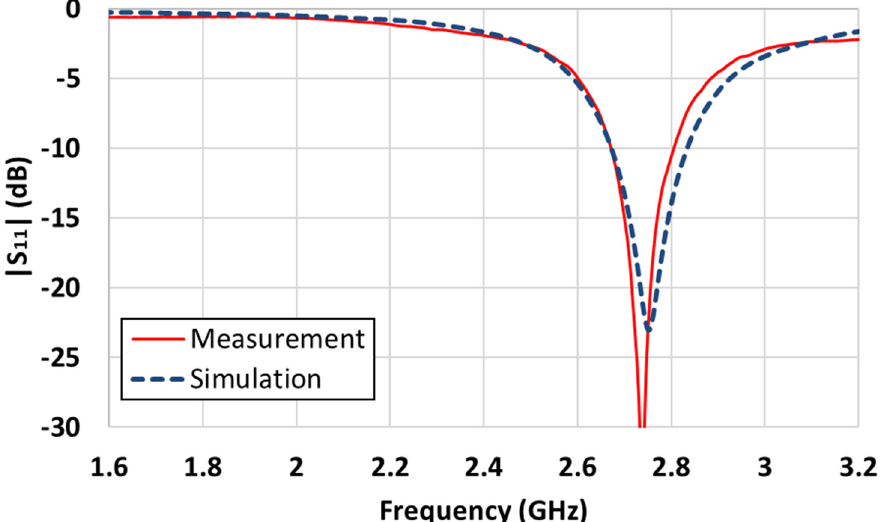
Figure 7. Constructed antenna: ( a ) complete structure, ( b ) patch antenna for feed.